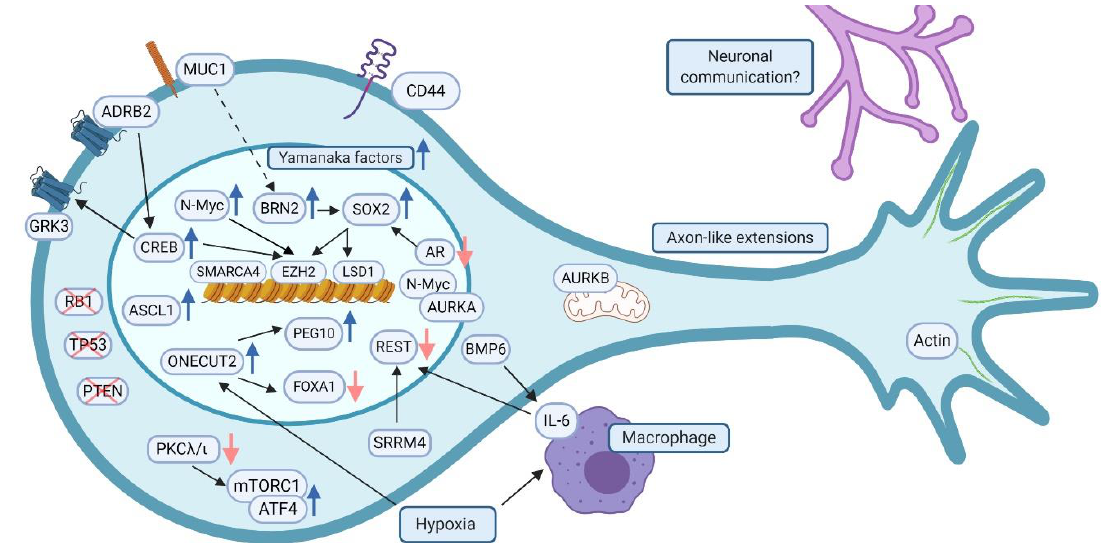
Figure 2. Overview of the molecular determinants of t-NEPC progression. Loss of RB1, TP53 and PTEN and increased expression of BRN2, NANOG, ASCL1, N-Myc and Yamanaka factors, such as SOX2, contribute to t-NEPC progression. CREB, activated by ADRB2, promotes EZH2 and GRK3 expression. Epigenetic modulators SMARCA4, EZH2 and LSD1 affect t-NEPC-like chromatin landscape. Increased MUC1 expression relates to increased BRN2 expression. CD44 is highly expressed in t-NEPC and it contributes to molecular interactions and signaling. BMP6 secreted by cells increases expression of IL-6 by macrophages. IL-6 and SRRM4 have inhibiting effect on REST. REST suppressed ONECUT2 expression is enhanced as a response to hypoxia/REST inhibition promoting the expression of PEG10 and SMAD3 and suppressing the expression of FOXA1. PKCλ/ι loss promotes mTORC1 complex activation and allows ATF4 to enhance the expression of genes involved in t-NEPC progression. AURKA protects N-Myc from degradation while AURKB has been shown to be involved with mitochondrial trafficking. Neuron-like appearance of t-NEPC is supported by actin, which is found in the neurite-like protrusions. Communication between neurons and cancer could be also involved in the t-NEPC progression. Figure was created with BioRender.com.